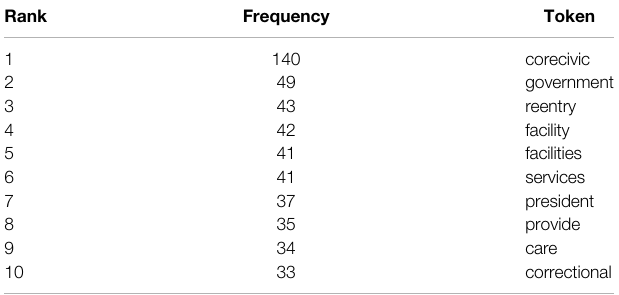
TABLE 1 | 10 most common content words in the CoreCivic